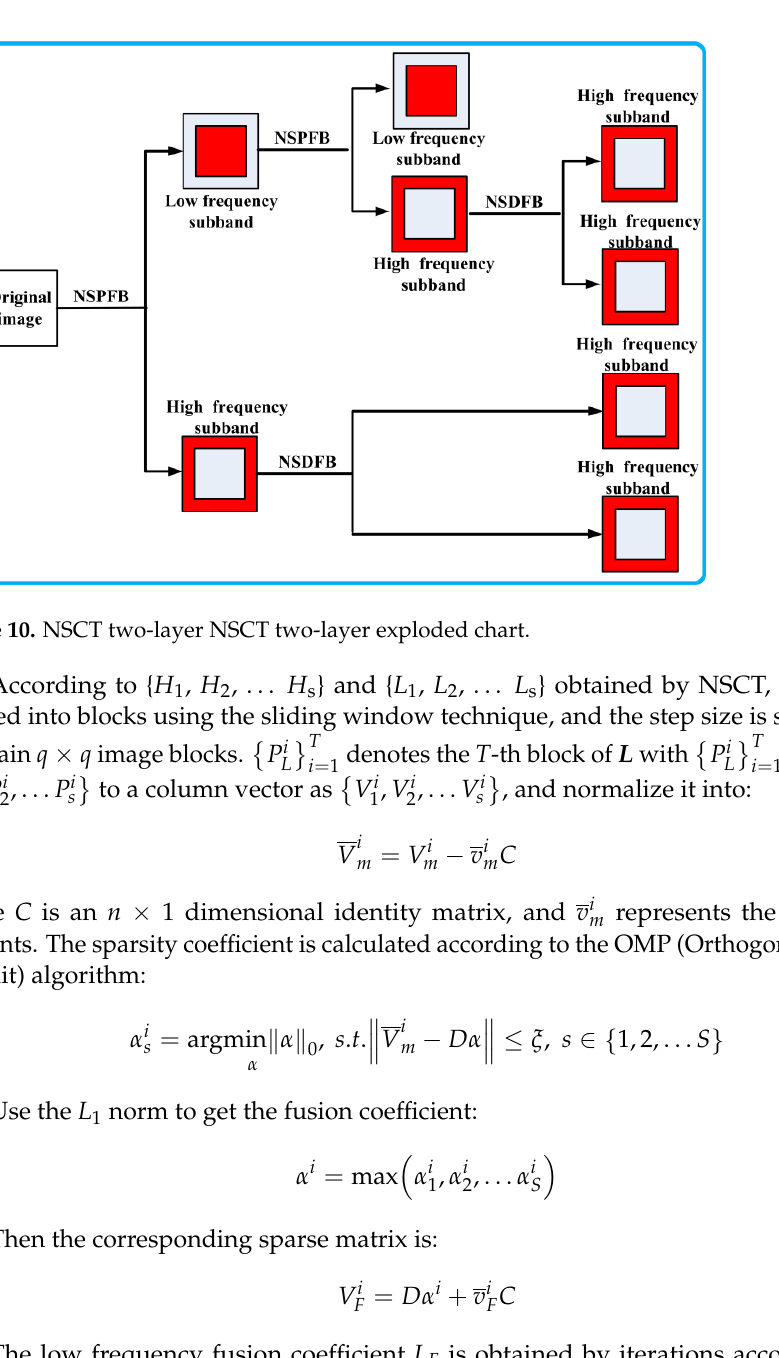
above steps. The high frequency sub band image contains rich edge information and contains a large amount of structural information at different scales. For this reason, we design an algorithm to fully utilize the high frequency sub band image. Since the average gradient can reflect the grayscale changes on both sides of the boundary, it can be used to measure image clarity. This principle is used to build high frequency fusion rules. The average gradient value G of the high frequency sub band image is given